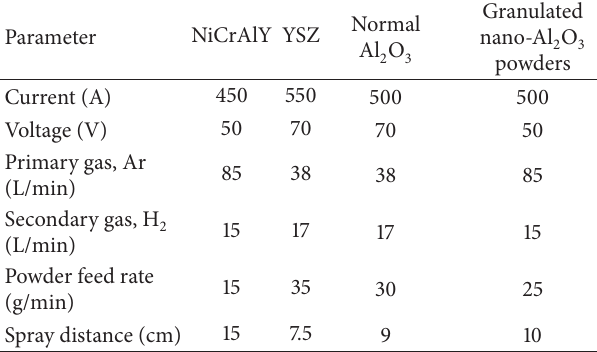
Table 1: The parameters of atmospheric plasma spraying